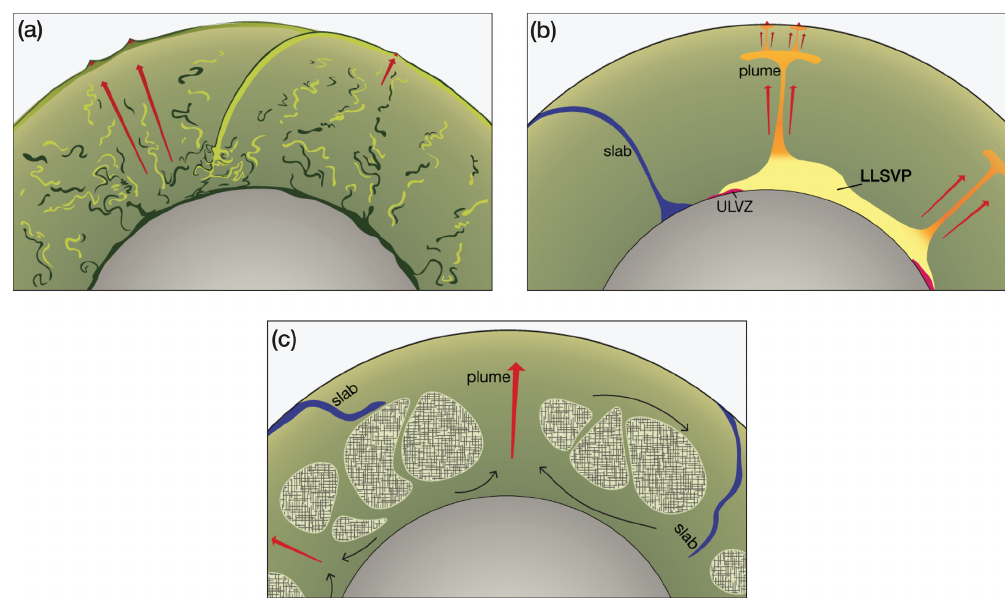
Figure 1. Several conceptual models of mantle compositional structure with heterogeneity on various scales. For explanations regarding these heterogeneity styles, the reader is referred to the text: (a) “marble cake” mantle, modified following Xu et al. (2008); Woodhead (2015); (b) thermochemical piles, modified after Deschamps et al. (2015); and (c) viscous “blobs”, modified after Becker et al. (1999); Ballmer et al.